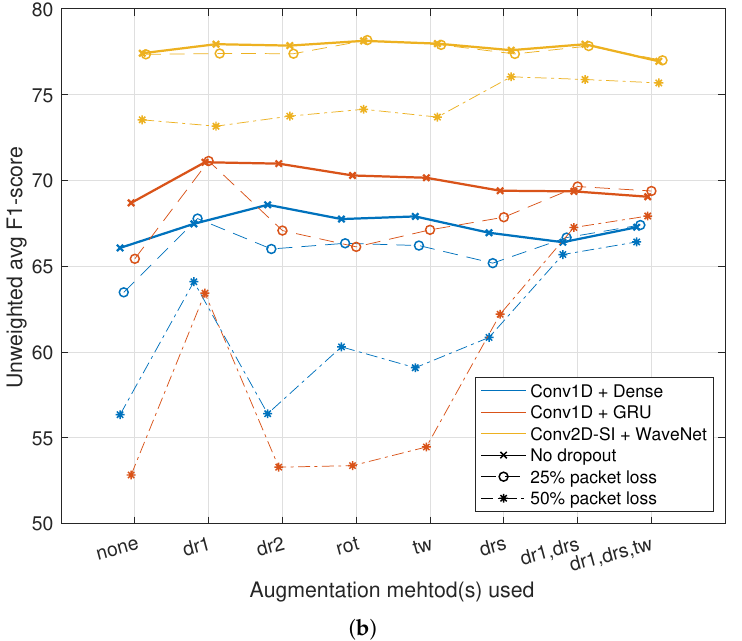
Figure 9. Classifier model robustness to noise and the effect of data augmentation. Augmentation method key: dr1 = input dropout; dr2 = bottleneck dropout; rot = rotation; tw = time warping; drs = sensor dropout. ( a ) Sensor dropout results. ( b ) Packet loss